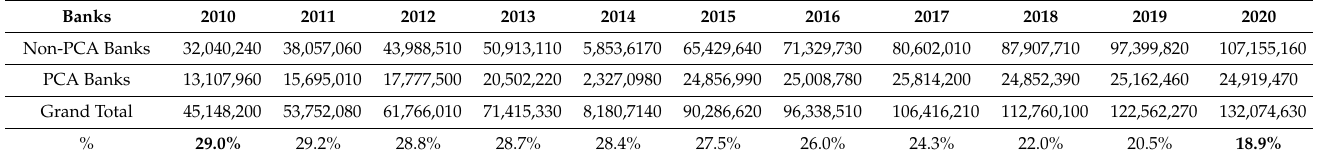
Table A1. Comparison of Deposit Share of PCA and Non-PCA Banks (in INR million).